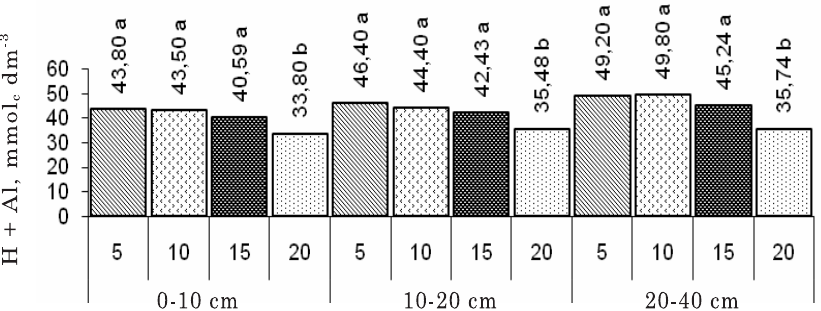
Figura 5. Teores de H + Al no solo para a interação Ofertas x Profundidades. Médias acompanhadas de mesma letra, dentro de profundidade, não diferem estatisticamente entre si pelo teste de Tukey.